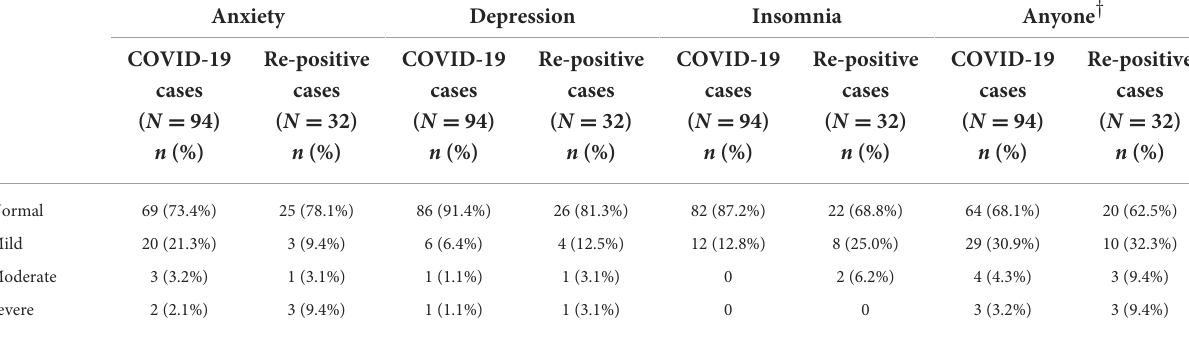
TABLE 1 The prevalence and severity of anxiety, depression, and insomnia among COVID-19 patients. Anxiety Depression